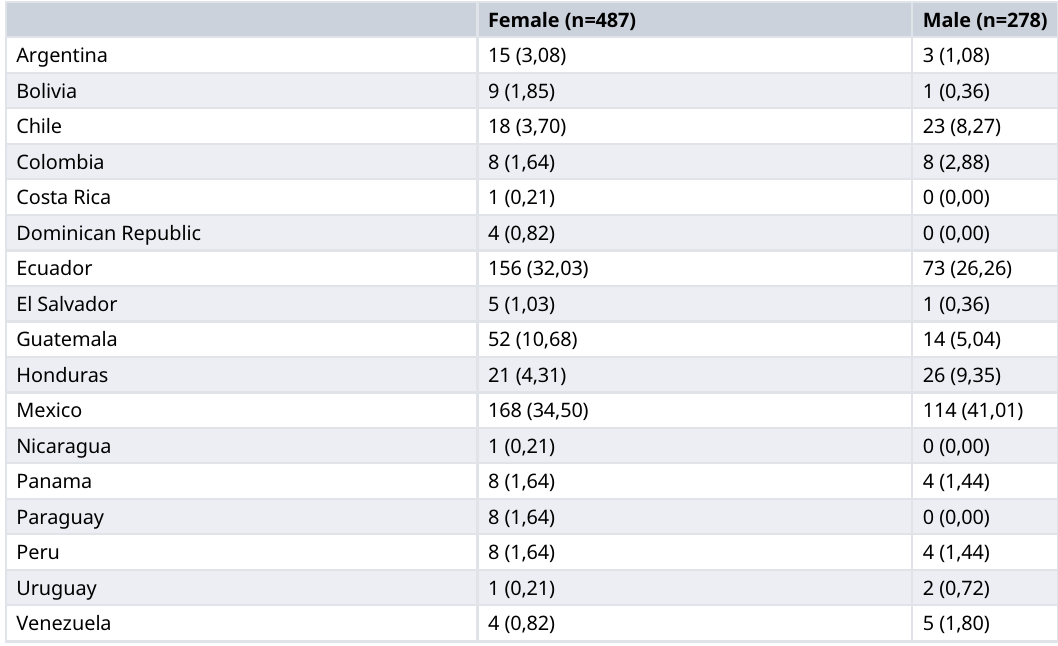
Table 1. Distribution by gender of medical students from Latin America.